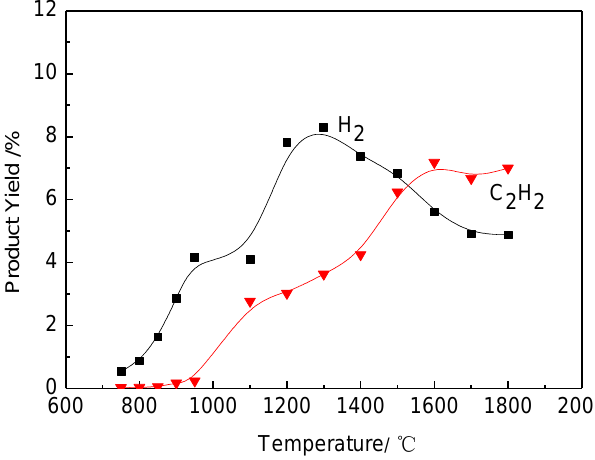
Figure 2. Influence of temperature on the yields of H 2 and C 2 H 2.